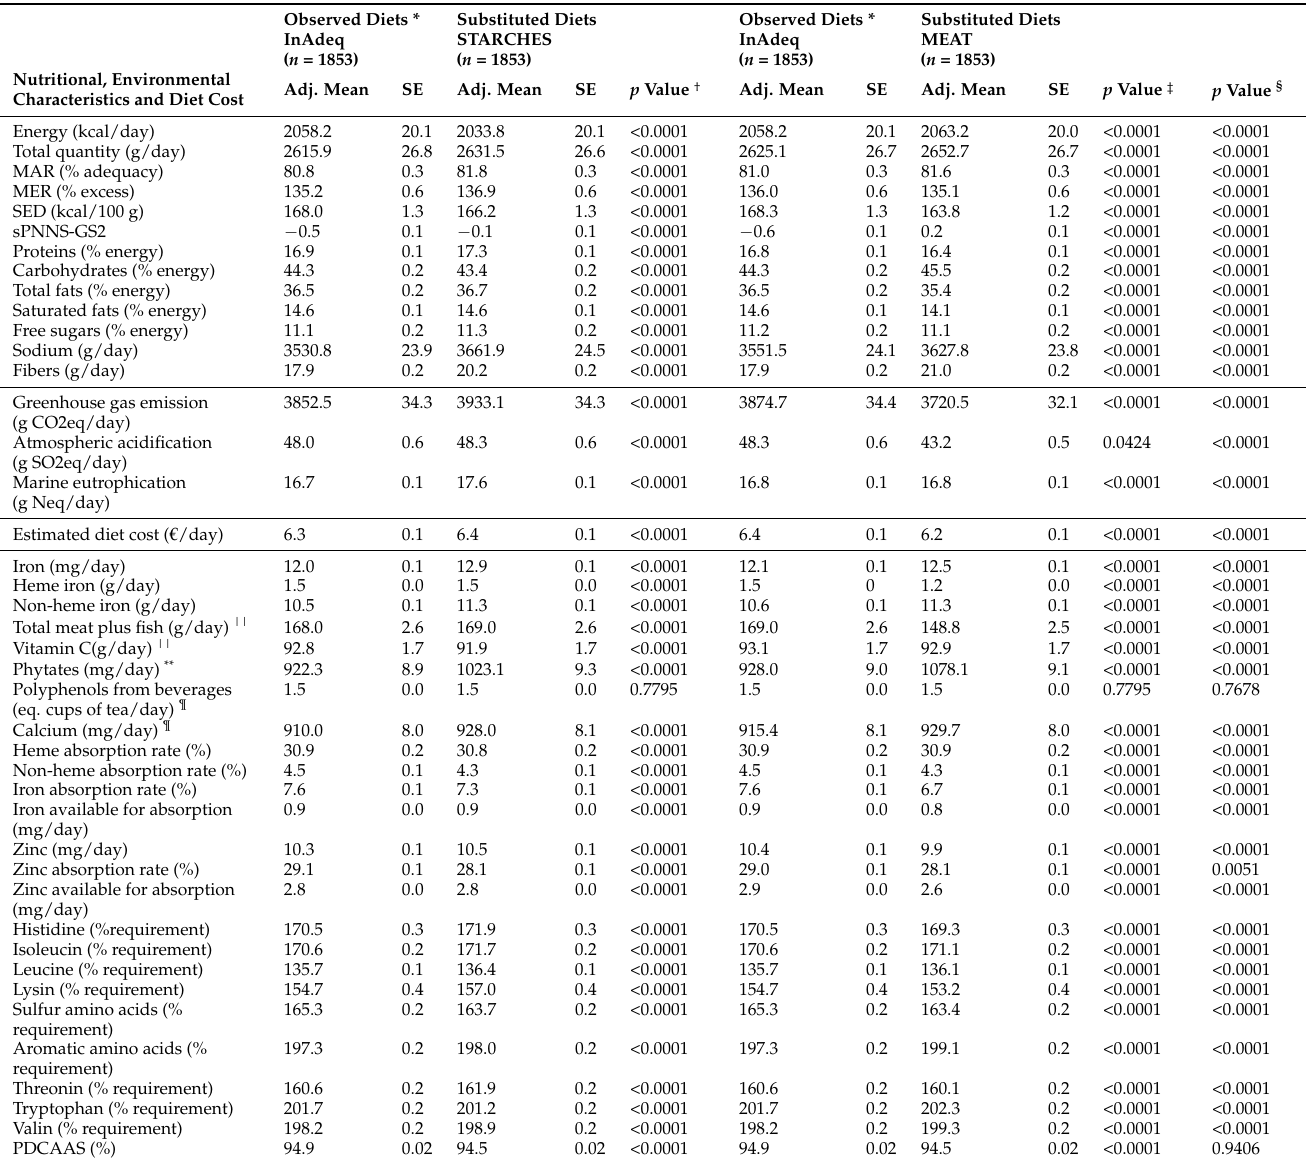
Table 5. Nutritional, environmental characteristics and estimated diet cost of observed diets not meeting the recommended guideline for pulses (InAdeq), and of substituted diets obtained with the STARCHES scenario (iso-portion replacement of starches with pulses until the recommended guideline for pulses is reached, i.e., 57 g/day) and with the MEAT scenario (iso-portion replacement of meat with pulses until the recommended guideline for pulses is reached). Values are means adjusted * for energy intake and standard